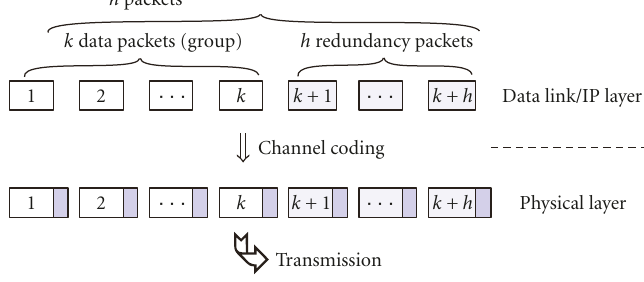
Figure 5: Packet level FEC